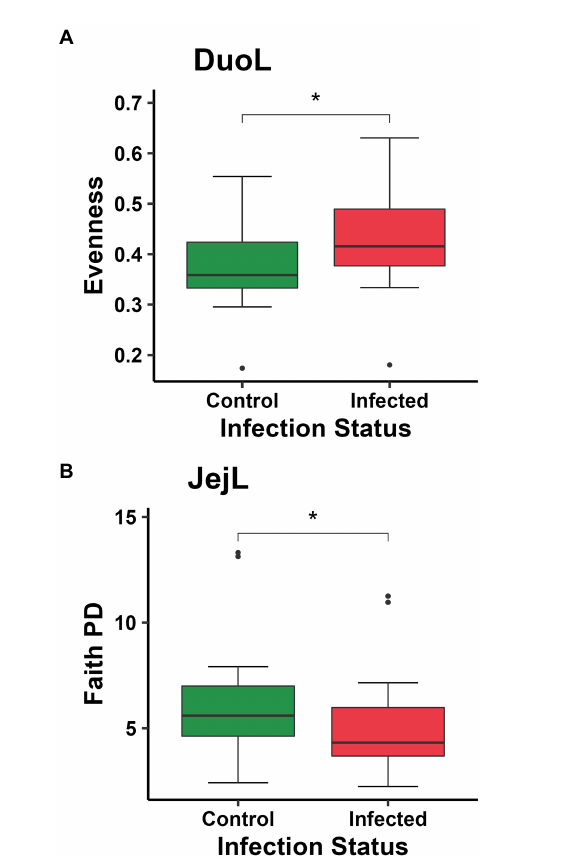
FIGURE 2 Comparisons of: (A) evenness between control and Eimeria acervulina -infected birds in duodenal luminal (DuoL) microbiota; (B) Faith’s phylogenetic diversity (Faith PD, richness) between control and Eimeria acervulina -infected birds in jejunal luminal (JejL) microbiota. Stars (*) denote statistically significant ( p < 0.05)